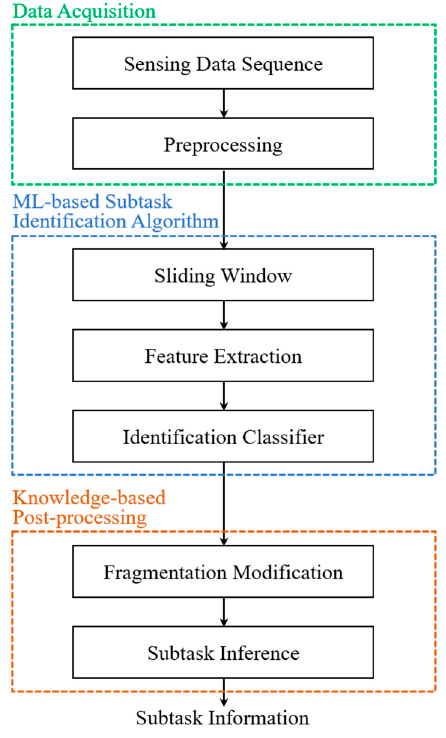
Figure 3. The functional diagram of the subtask identification system.